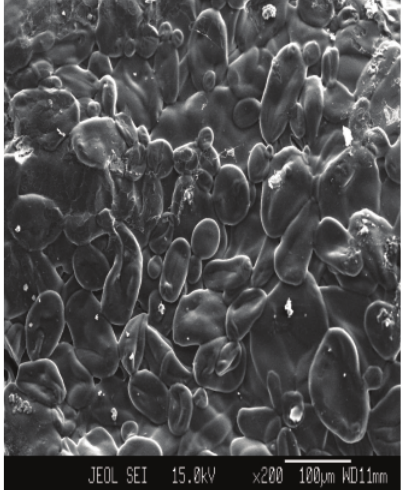
Figure 4: SEM micrograph of the complexed